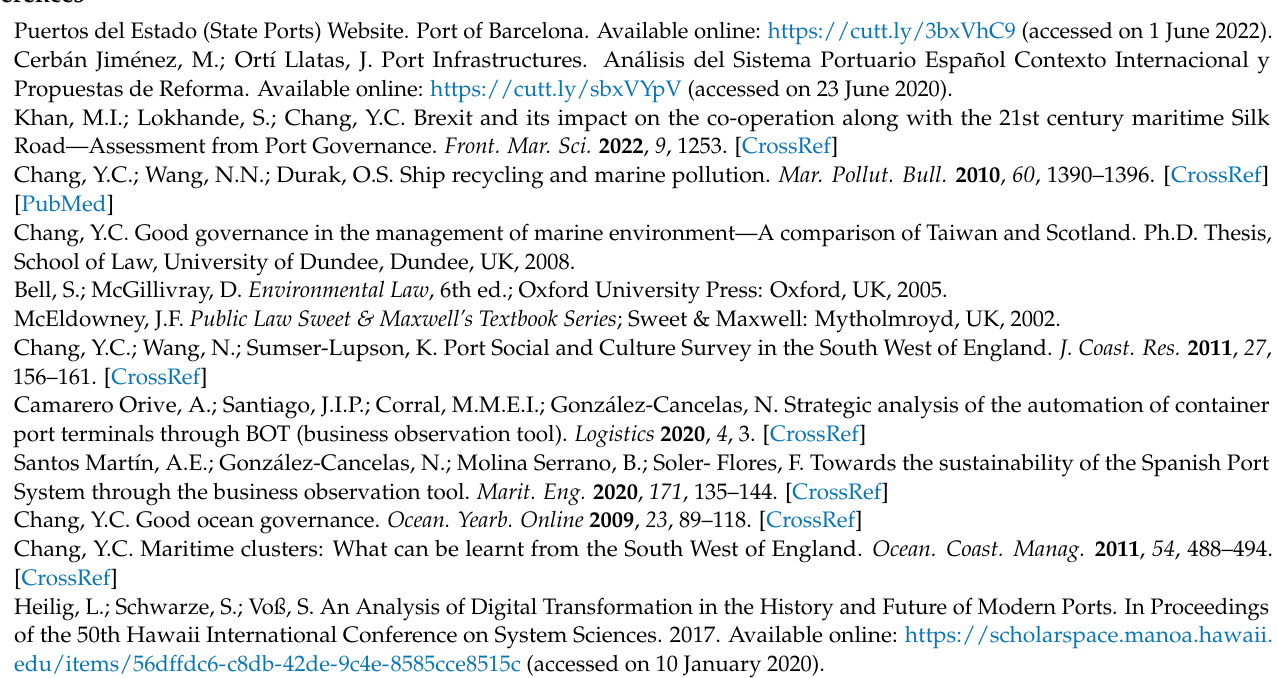
develop digital governance models will have to develop mainly technological